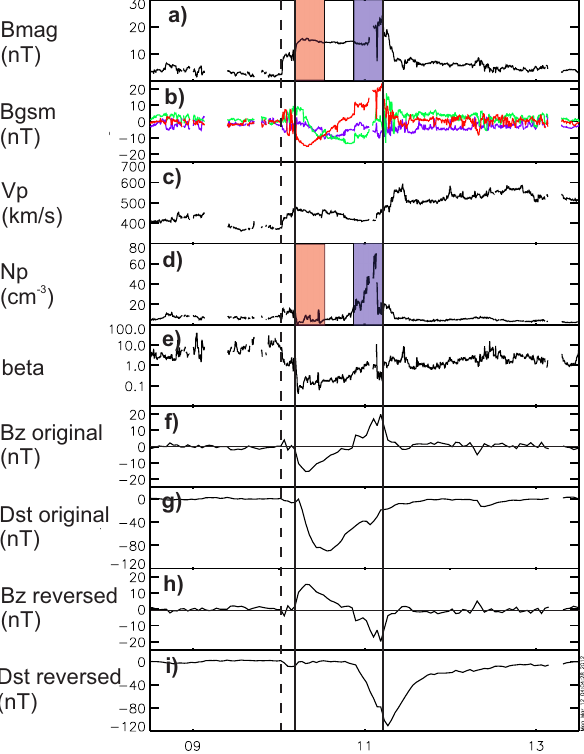
Fig. 2. An example of a bipolar SN-type magnetic cloud detected on 10–11 January 1997. The solar wind plasma and magnetic field measurements are from the OMNI-data base. The panels from top to bottom give: (a) magnetic field magnitude, (b) magnetic field com- ponents in GSM-coordinate system (purple: B X , green: B Y , red: B Z , (c) solar wind speed, (d) density, and (e) plasma beta. Pan- els (f) and (h) give the 1-h measured and reversed B Z , respectively, and panels (g) and (i) Dst predicted from the modified Burton et al. (1975) formula (see text) using the measured and reversed B Z , respectively. The magnetic cloud interval is bounded between a pair of solid lines and the interplanetary shock is indicated by a dashed line. In panels (a) and (d) red-shaded (blue-shaded) regions indicate the intervals that were used to calculated leading (trailing) magnetic field magnitude and